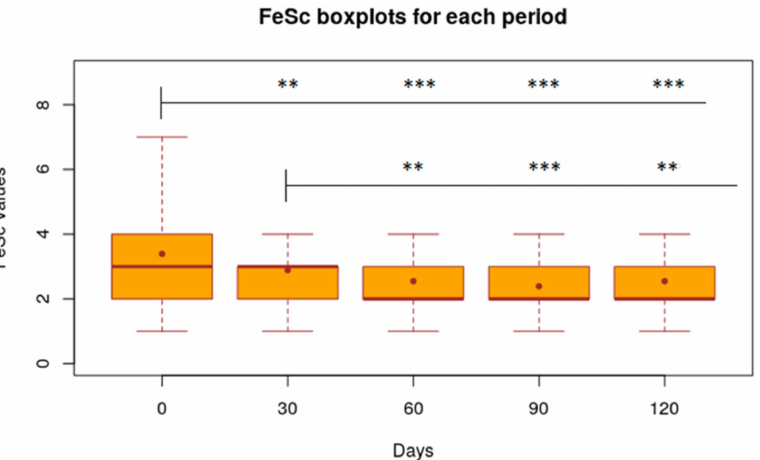
Figure 4. Statistical results of FeSc values calculated for each period. Boxplot of FeSc value of 32 dogs at time 0, 30, 60, 90, 120 days. Level of Significance compared to time 0 and 30 days: *** 1%; ** 5%; * 10%.